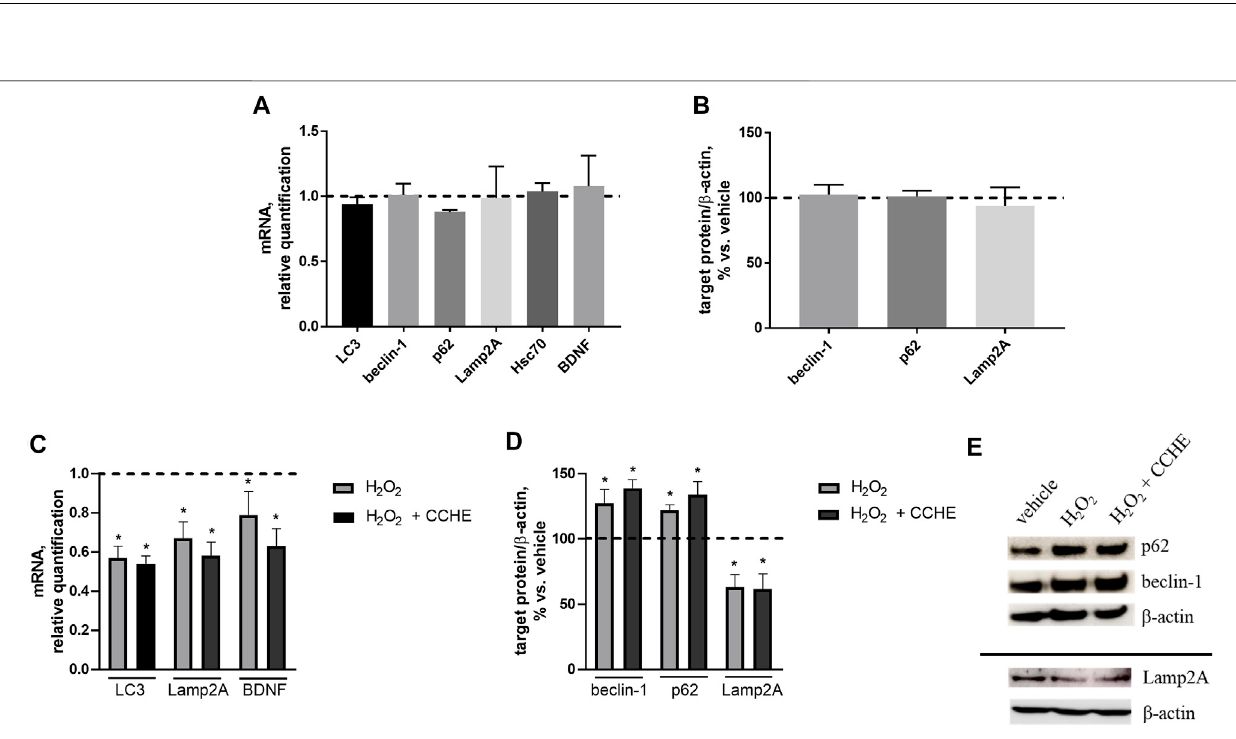
Frontiers in Chemistry |